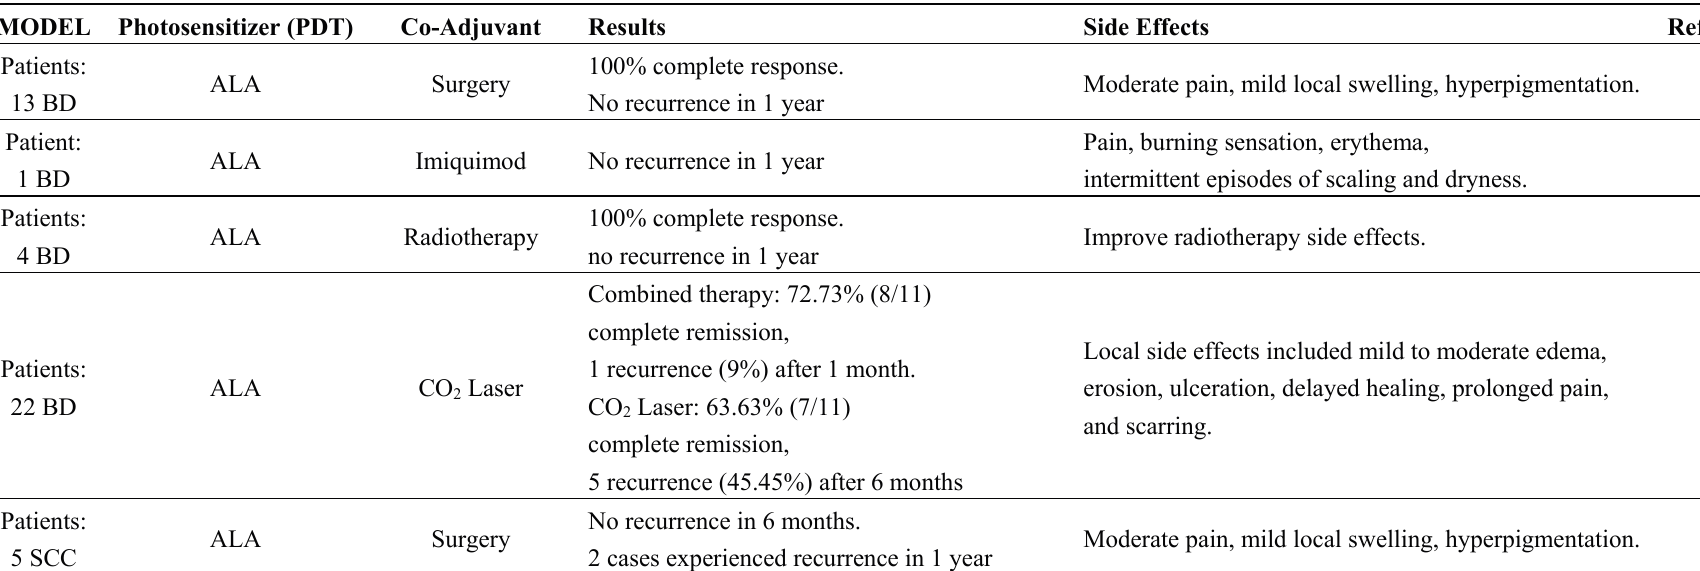
Table 2. Clinical studies of combined treatments with photodynamic therapy for squamous cell carcinoma. MODEL